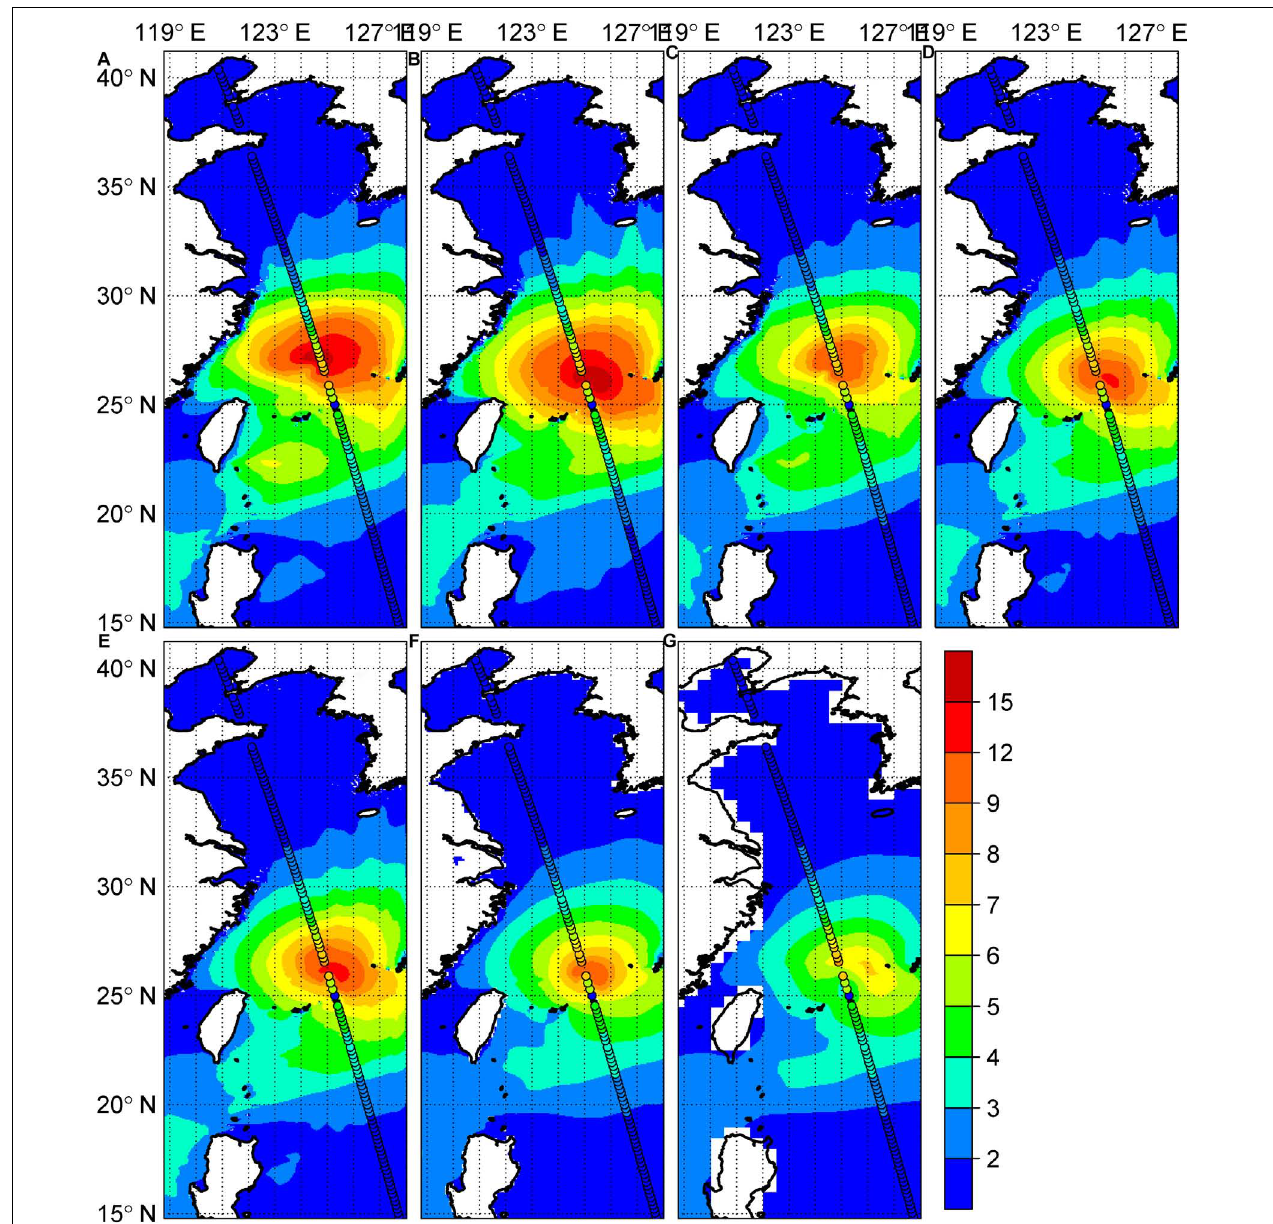
FIGURE 6 | Snapshots of the modeled significant wave height (m) at 13:00 UTC 5 September 2019 for (A) 1w_wind, (B) 1w_wind_SN, (C) 2w_new, (D) 2w_new_SN, (E) 2w_old_SN, (F) ECMWF, and (G) ERA5. The overlapping points represent the Sentinel-3B satellite